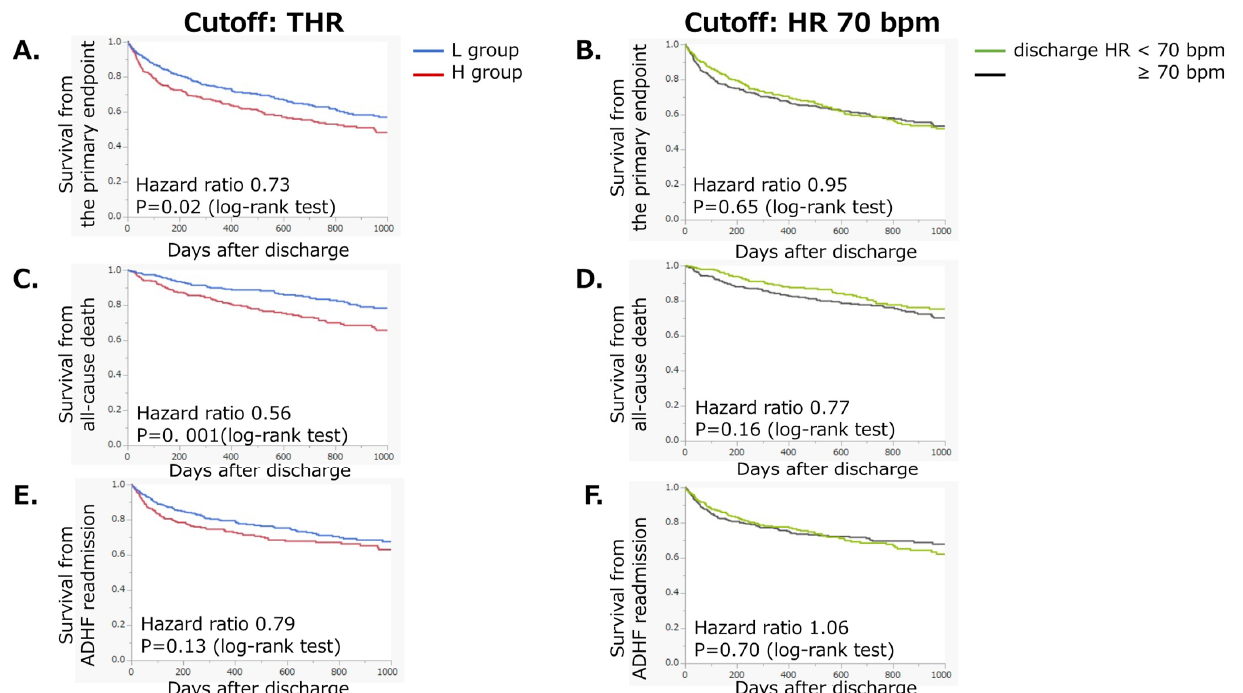
Figure 2. Kaplan-Meier curves for ( A , B ) the primary endpoint, ( C , D ) all-cause death, and ( E , F ) ADHF readmission dividing the study population according to discharge HR by a cutoff of THR or 70 bpm. The primary endpoint was defined as a composite of all-cause death and ADHF readmis- sion. ADHF: acute decompensated heart failure, discharge HR: heart rate at discharge, THR: target heart rate.